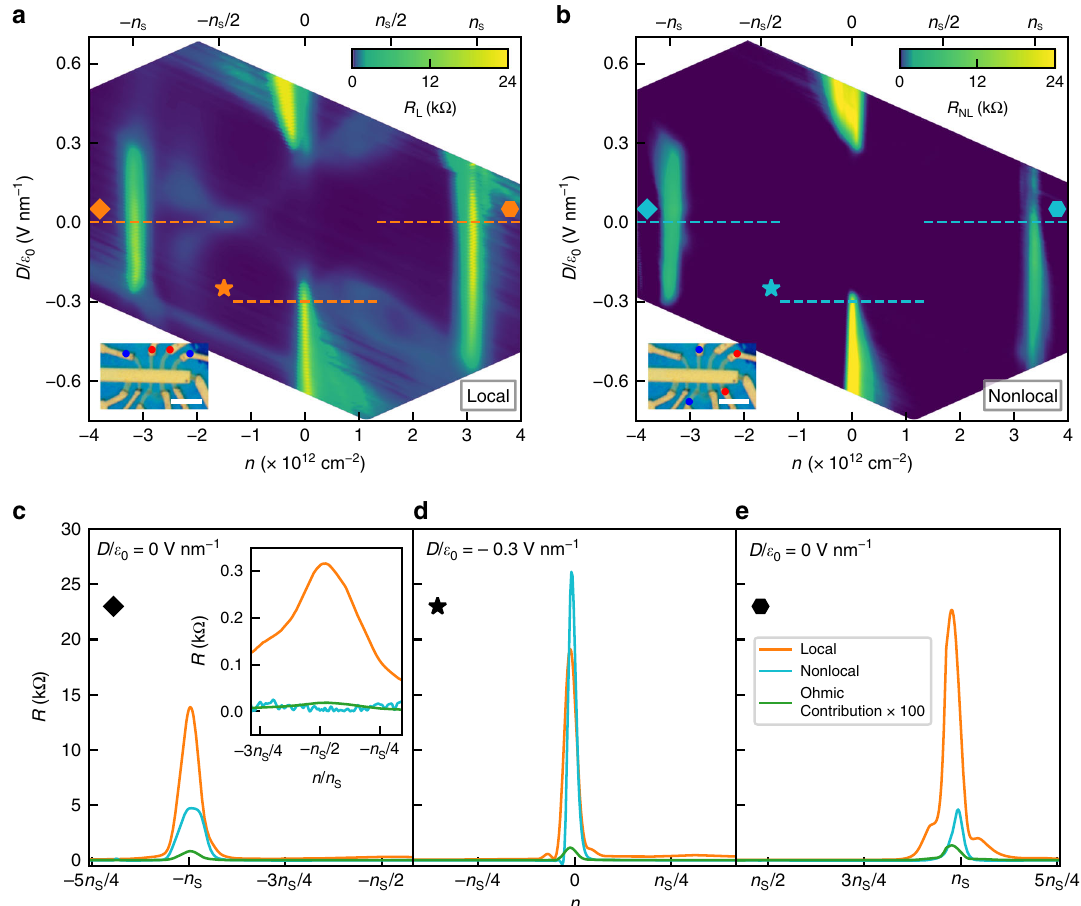
Fig. 2 Local and nonlocal resistance in TDBG device with twist angle 1.18° at 1.5 K. a , b Local and nonlocal resistance as a function of charge density and electric fi eld. The dashed overlay line shows the location of line slices plotted in c – e . n S denotes the charge density to fi ll one moiré fl at band. Insets show the micrographs of the device with voltage (current) terminals indicated by red (blue) dots. The scale bar corresponds to 5 μ m. c – e Both local and nonlocal resistance, along with the calculated ohmic contribution, around moiré gaps at n = − n S ( c ), and n = n S ( e ) for the zero electric fi eld and around the CNP gap at n = 0 ( d ) for a nonzero electric fi eld. The nonlocal resistance is much larger than the ohmic contribution at the gaps. The inset in c zooms the resistance variation around n = − n S /2 at D / ϵ 0 = 0 V nm − 1 , where nonlocal resistance is almost zero in spite of signi fi cant local